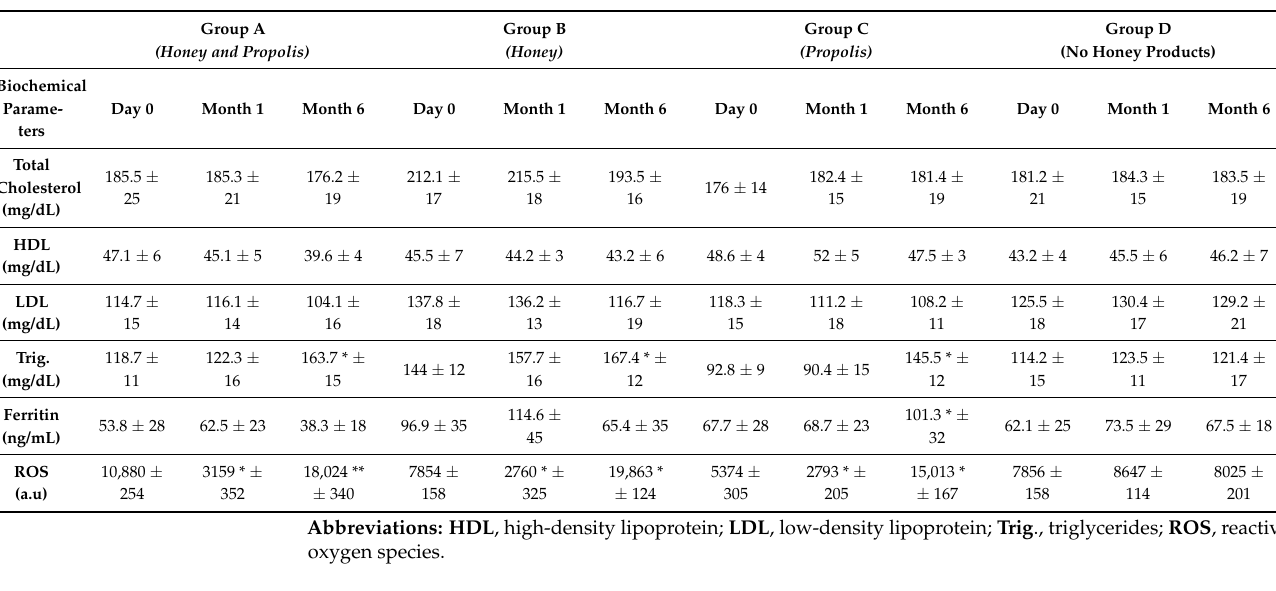
Table 2. Biochemical parameters and ROS levels of the regular blood donors before and after honey and/or propolis consumption. Data are the averages ± SDs of the 3 measurements. Significant differences from day 0 are represented as * p < 0.05 and ** p < 0.001.